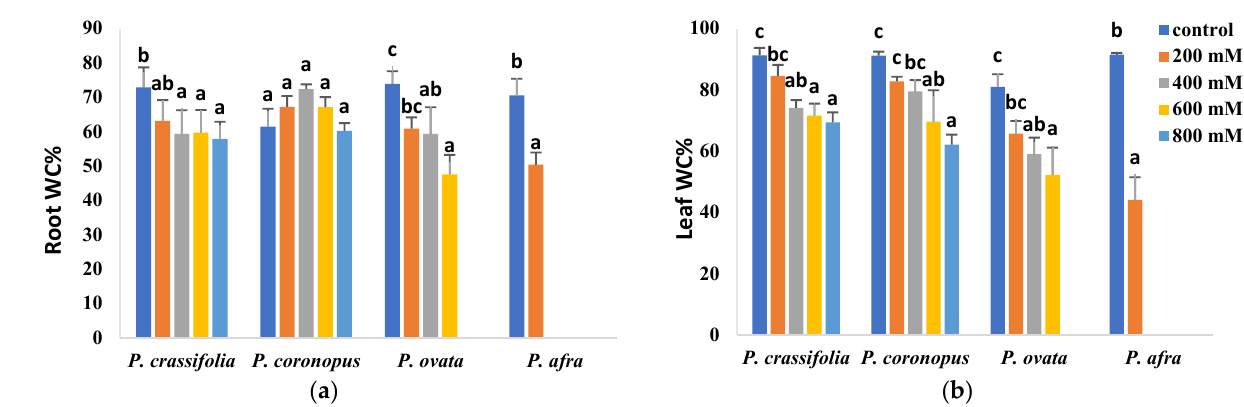
Figure 3. Water content percentage in roots ( a ) and leaves ( b ) in the four selected Plantago species, after four weeks of treatment with the indicated NaCl concentrations. The values shown are means ± SE ( n = 5). For each species, different letters over the bars indicate significant differences between treatments, according to the Tukey test ( p < 0.5).